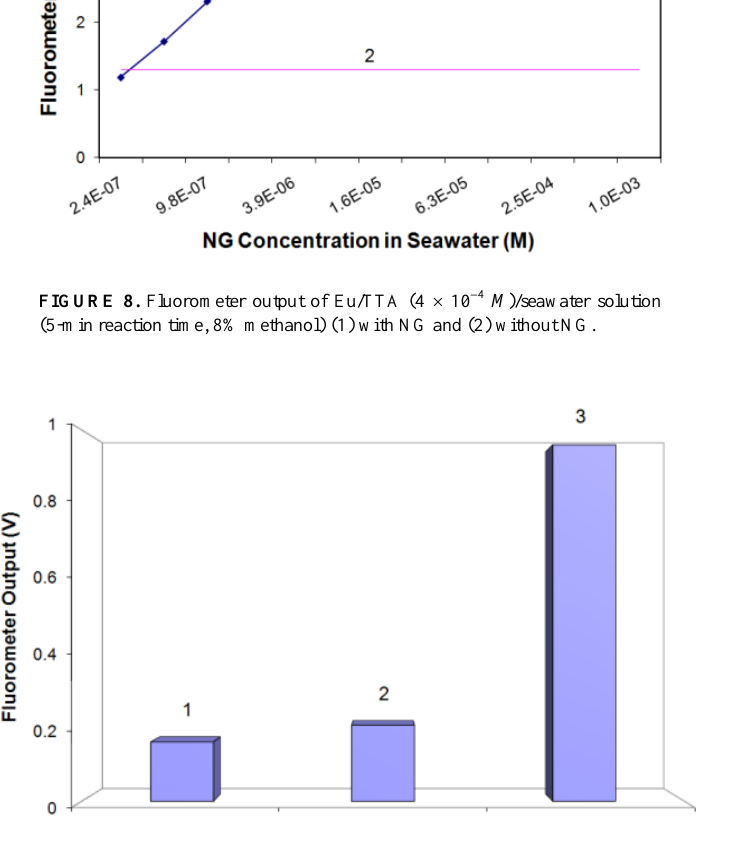
FIGURE 9. Flowing setup detector output. (1) Seawater only; (2) seawater and Eu/TTA (2  10 – 4 M ); (3) seawater, NG (5  10 – 4 M ), and Eu/TTA (2  10 – 4 M ). The reagent solvent (methanol) comprised 8% of each solution that included